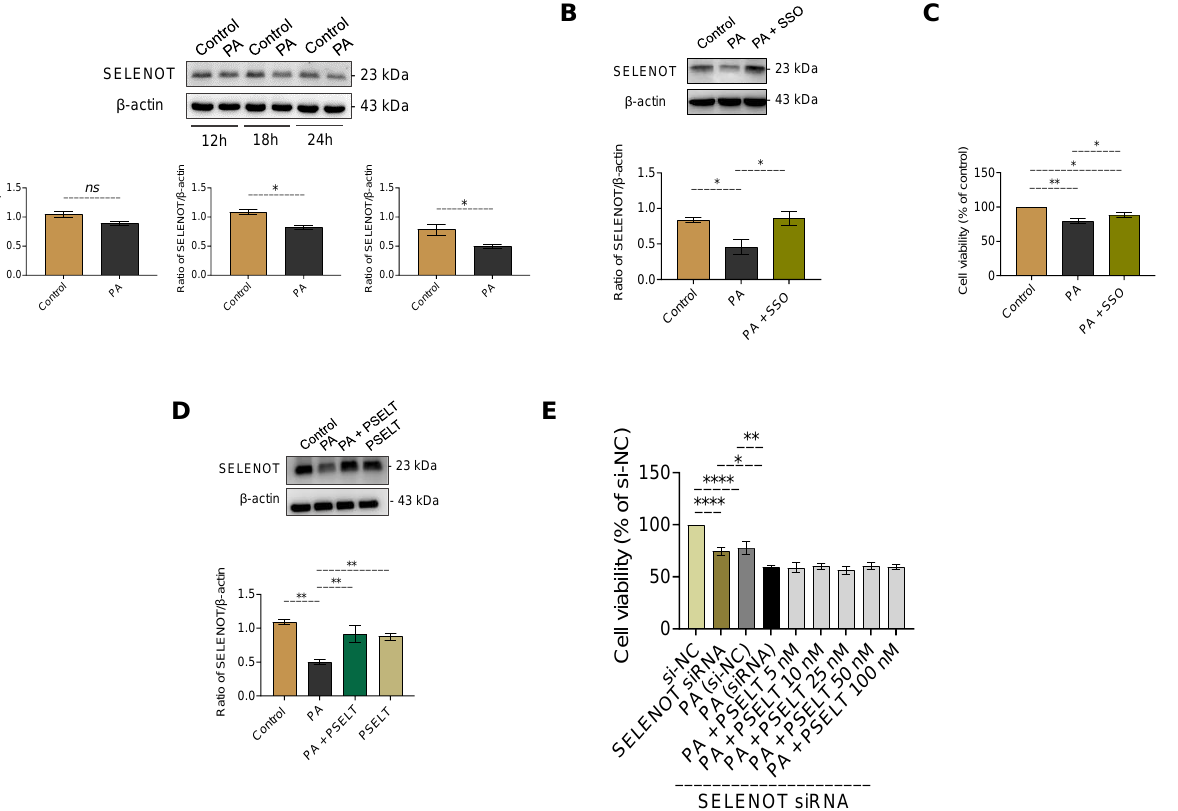
Figure 3. Effect of PA and PSELT on endogenous SELENOT expression and the role of SELENOT in PSELT-induced cell protection against PA in H9c2 cardiomyocytes. ( A ) Effect of PA on endogenous SELENOT expression at different times. Western blot analysis of SELENOT in H9c2 cardiomyocytes treated with vehicle (Control) or PA 100 µ mol/L for 12 h, 18 h, and 24 h. Histograms represent the ratio of the densitometric analysis of protein:loading control. Data are expressed as the mean ± SEM, and significant differences were detected by t -tests; p < 0.05 (*). ( B ) Representative Western blot analysis of SELENOT in H9c2 cardiomyocytes treated with vehicle (Control), PA 100 µ mol/L, or sulfosuccinimidyl oleate (SSO) 1 µ mol/L for 1 h, an irreversible inhibitor of CD36 + PA, for an additional 24 h. Data are expressed as the mean ± SEM ( n = 3 independent experiments). ( C ) MTT assay in H9c2 cardiomyocytes exposed to vehicle (Control), PA 100 µ mol/L, or SSO 1 µ mol/L for 1 h (an irreversible inhibitor of CD36) + PA for an additional 24 h. Cell viability was expressed as the percentage of control cells exposed only to vehicle (indicated as Control). ( D ) Western blot analysis of SELENOT in H9c2 cardiomyocytes treated with vehicle (Control), PA 100 µ mol/L, PA + PSELT 5 nmol/L or PSELT for 24 h. Data are expressed as the mean ± SEM ( n = 3 independent experiments). Histograms represent the ratio of the densitometric analysis of protein:loading control. ( E ) Effect of si-SELENOT gene silencing on cell viability in H9c2 cells treated with PA 100 µ mol/L alone and in the presence of increasing concentrations of PSELT (5–100 nmol/L) for 24 h. Cell viability was evaluated using MTT assay and was expressed as the percentage of control cells transfected only with the si-RNA-negative control (indicated as si-NC). Results are presented as the mean ± SEM ( n = 6 per group). Significant differences were detected by one-way ANOVA followed by Newman– Keuls multiple comparison test. p < 0.05 (*); p < 0.01 (**); and p < 0.0001